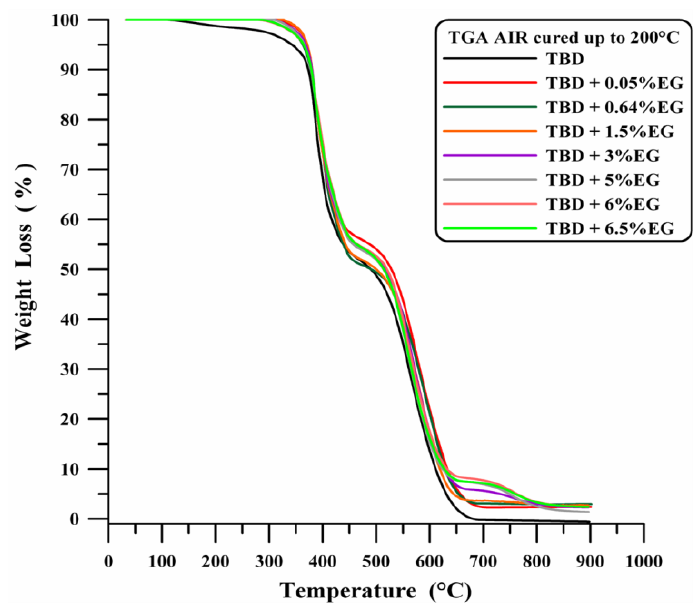
Figure 11. TGA curves in air of neat and EG based nanocomposites.